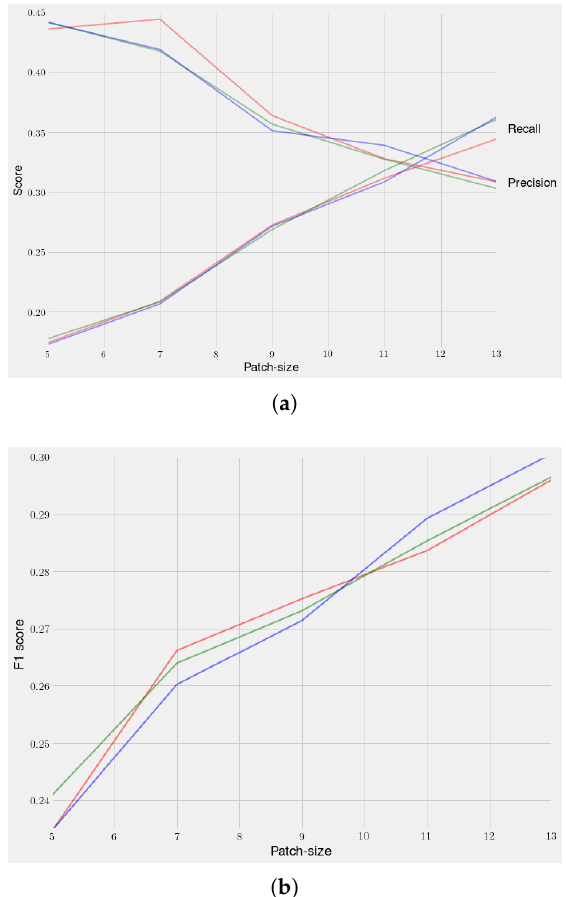
Figure 6. Average recall, Precision, and F1 Score depending on the patch size and sigma: σ = 5 in red σ = 7 in green σ = 9 in blue . ( a ) Recall and Precision depending on the patch size; ( b ) F1 Score depending on the Patch size.